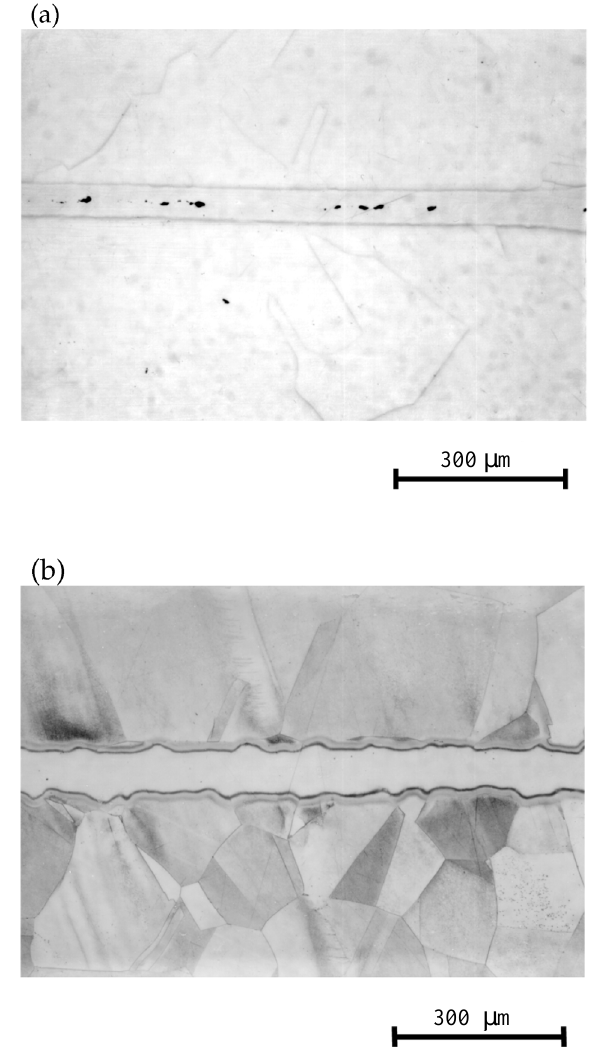
FIG. 10. Microstructures of the shim brazes made under vacuum furnace brazing conditions with induction heating at 250 ± C (cid:1) min: (a) pure gold braze showing centerline porosity and (b) Nioro braze with no